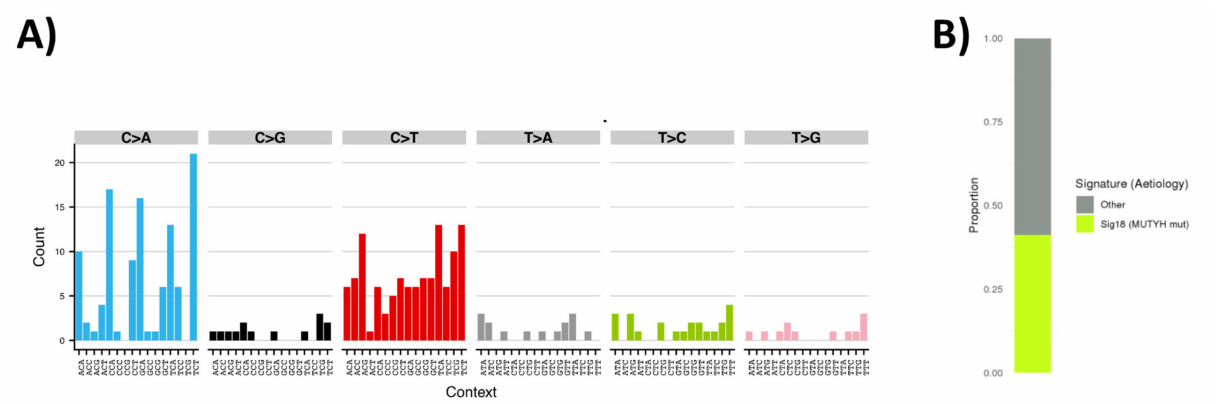
Figure 3. Somatic mutational signature analysis of the MUTYH germline variant carrier (suspected familial endometrial cancer cohort). ( A ) A total of 287 somatic single nucleotide variants (SNVs) identified in the endometrial tumor and used in signature analysis, plotted as counts in a 96 trinucleotide context. ( B ) The proportion of mutations in the tumor sample which were assigned to Signature